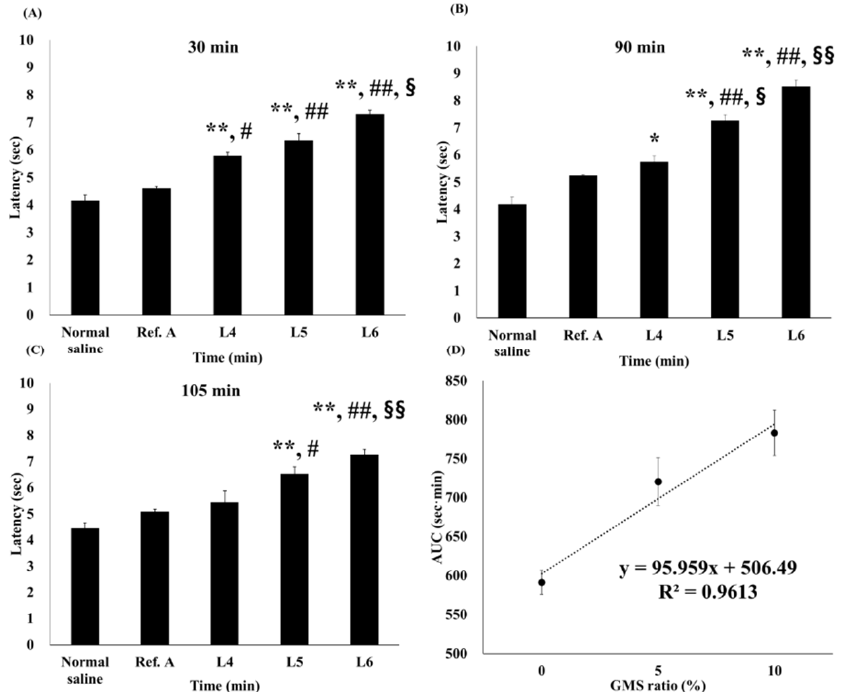
Figure 10. In vivo tail flick latency vs. time passed; comparison by concentration. The latency of in vivo tail-flick test at ( A ) 30, ( B ) 90 and, ( C ) 105 min; ( D ) Correlation between area under the curve (AUC) and glycerol monostearate (GMS) ratio (%) (mean ± standard error, n = 4). * ANOVA, LSD, p < 0.05, compared with the normal saline group. # ANOVA, LSD, p -value < 0.05, compared with Ref. A group. § ANOVA, LSD, p -value < 0.05 compared with L4 group. ** ANOVA, LSD, p -value < 0.005 compared with Normal saline group. ## ANOVA, LSD, p -value < 0.005 compared with Ref. A group. §§ ANOVA, LSD, p -value < 0.005 compared with L4 group.